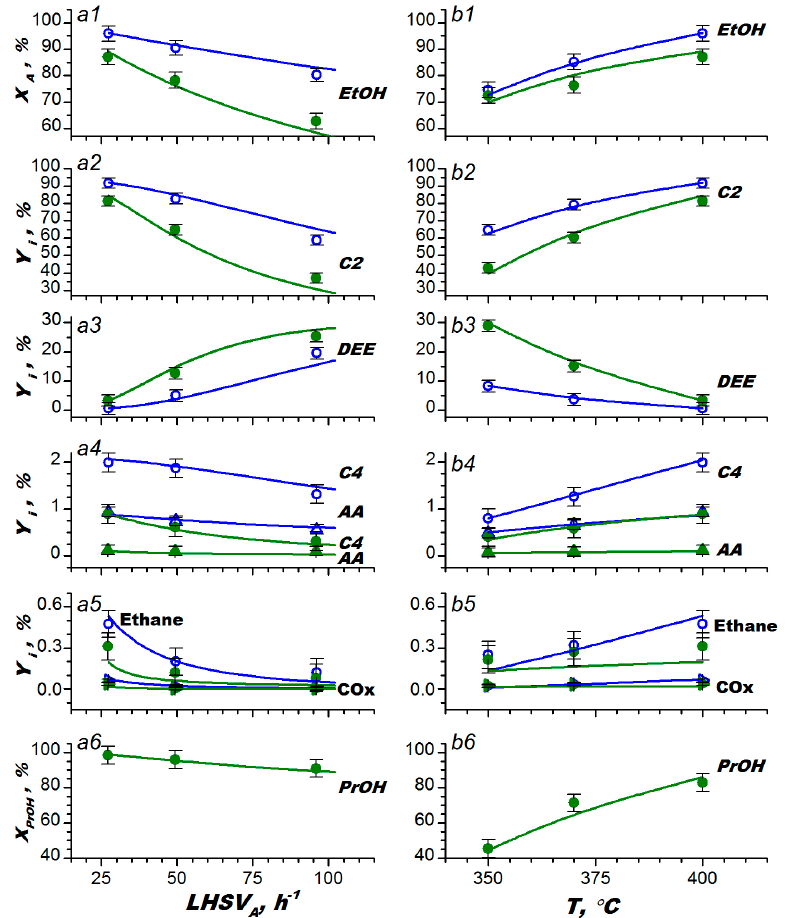
Figure 1. Effect of n-PrOH impurity in 92% wt feedstock on ethanol X A and propanol X PrOH conversions, and products yield Y i with variation in LHSV A at 400 ◦ C ( a1 – a6 ) and in T at LHSV A ~27 h –1 ( b1 – b6 ) for pure ethanol ( m0 , open), contaminated ethanol with n-PrOH of 0.01% ( m1 , semi- open) and 0.27% ( m3 , solid). C2 , DEE , C4 , ethane (circle), AA , and COx (triangle). Conditions: PFR ; proprietary Al 2 O 3 catalysts of 0.25–0.50 mm. Symbols indicate experiments; lines indicate calculations for PFR using the extended kinetic